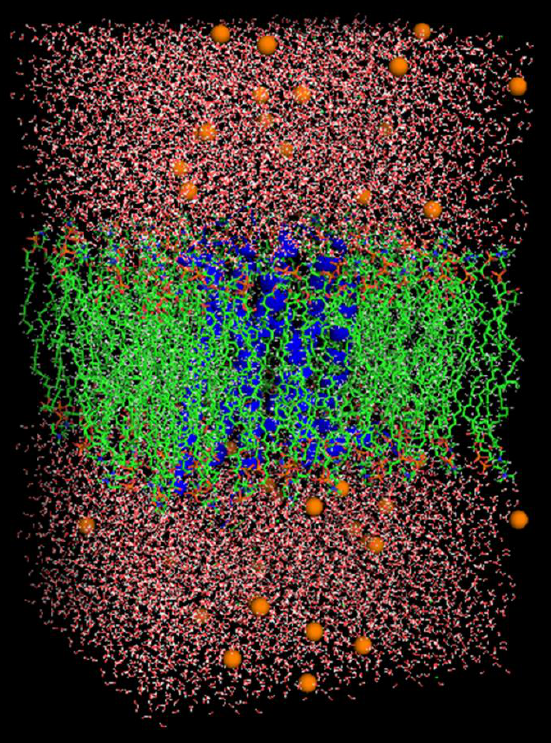
Figure 21. Lateral view of [(FXN)(PA)] complex incorporated in dipalmitoylphosphatidylcholine (DPPC) membrane in rectangular box solvated with water molecules and neutralized with 52 K + and 57 Cl − ions (0.15 M salt).